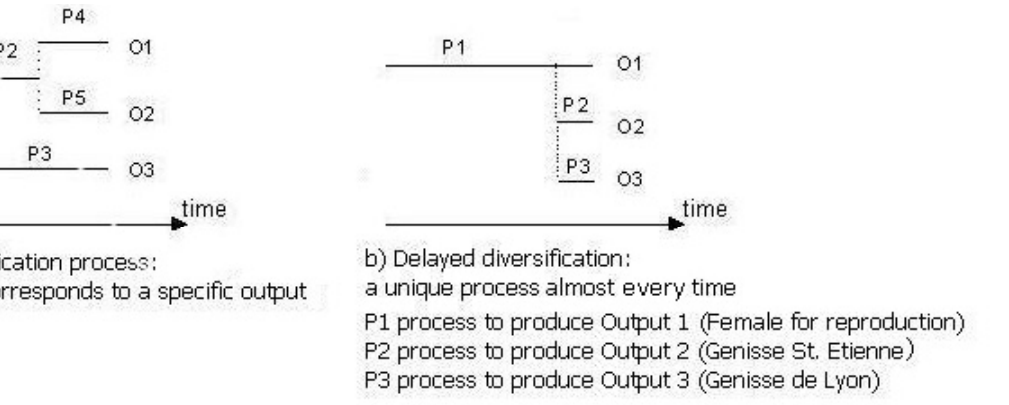
Fig. 4. Delayed diversification process (P) for the different outputs (O) produced by the Limousin extensive beef cattle farming systems (adapted from Fouquart